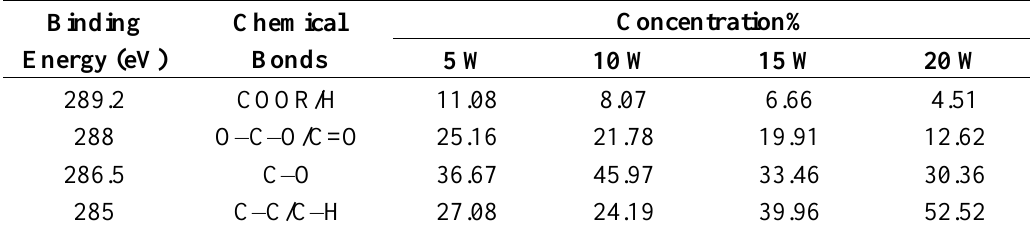
Table 1. C 1s binding energy and surface concentration from the XPS spectra of the plasma polymerized PEO-like film at 5 W, 10 W, 15 W, and 20 W.